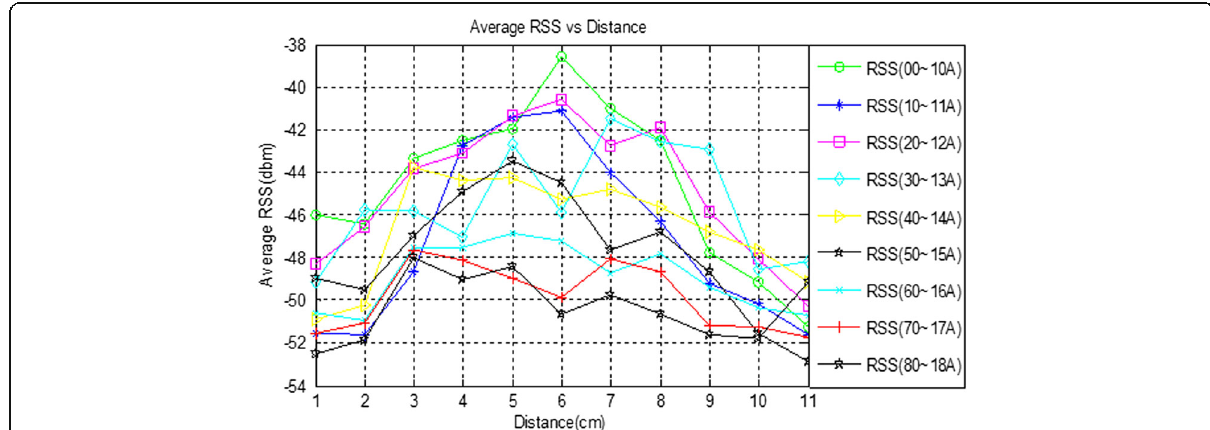
Fig. 11 Average RSS vs distance. The relationship between RSS energy distribution map and distance is closer to the center, and RSS energy becomes stronger